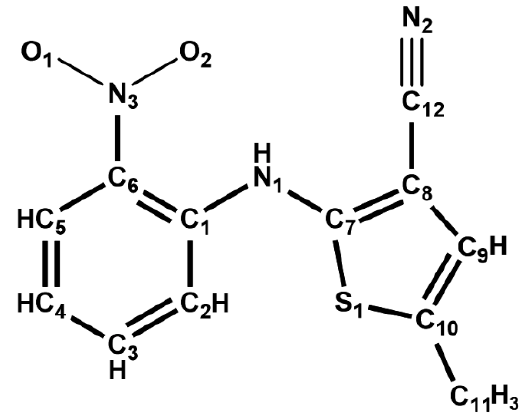
Figure 1. Molecular structure of